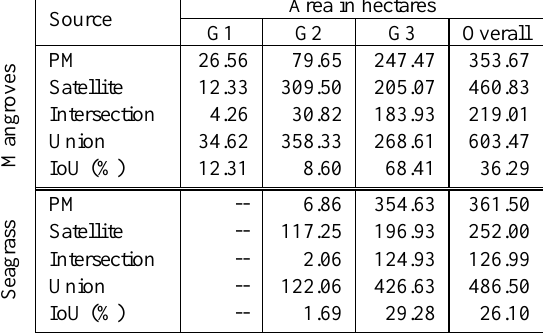
Table 2. Intersection-over-union (IoU) between participatory maps (PM) and satellite-based classified maps of mangroves and seagrass.